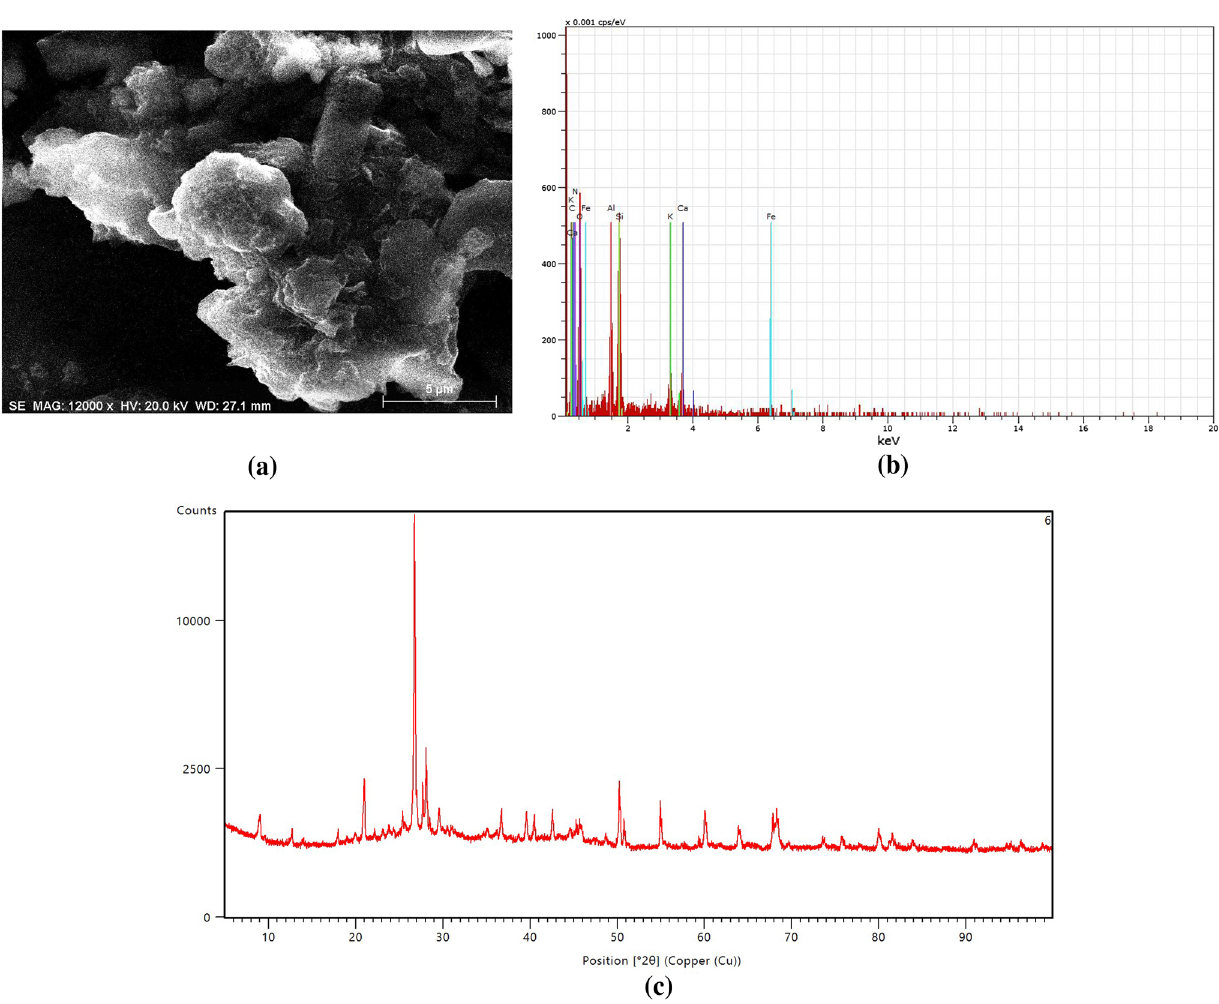
Fig. 6 SEM, EDS and XRD analyses of 40th day compost (Mandi